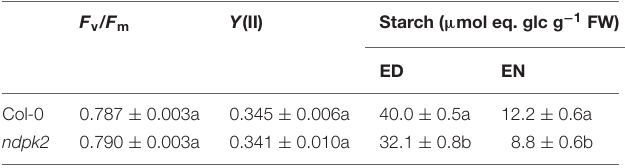
TABLE 3 | Chlorophyll fluorescence analysis and starch contents in ndpk2 and